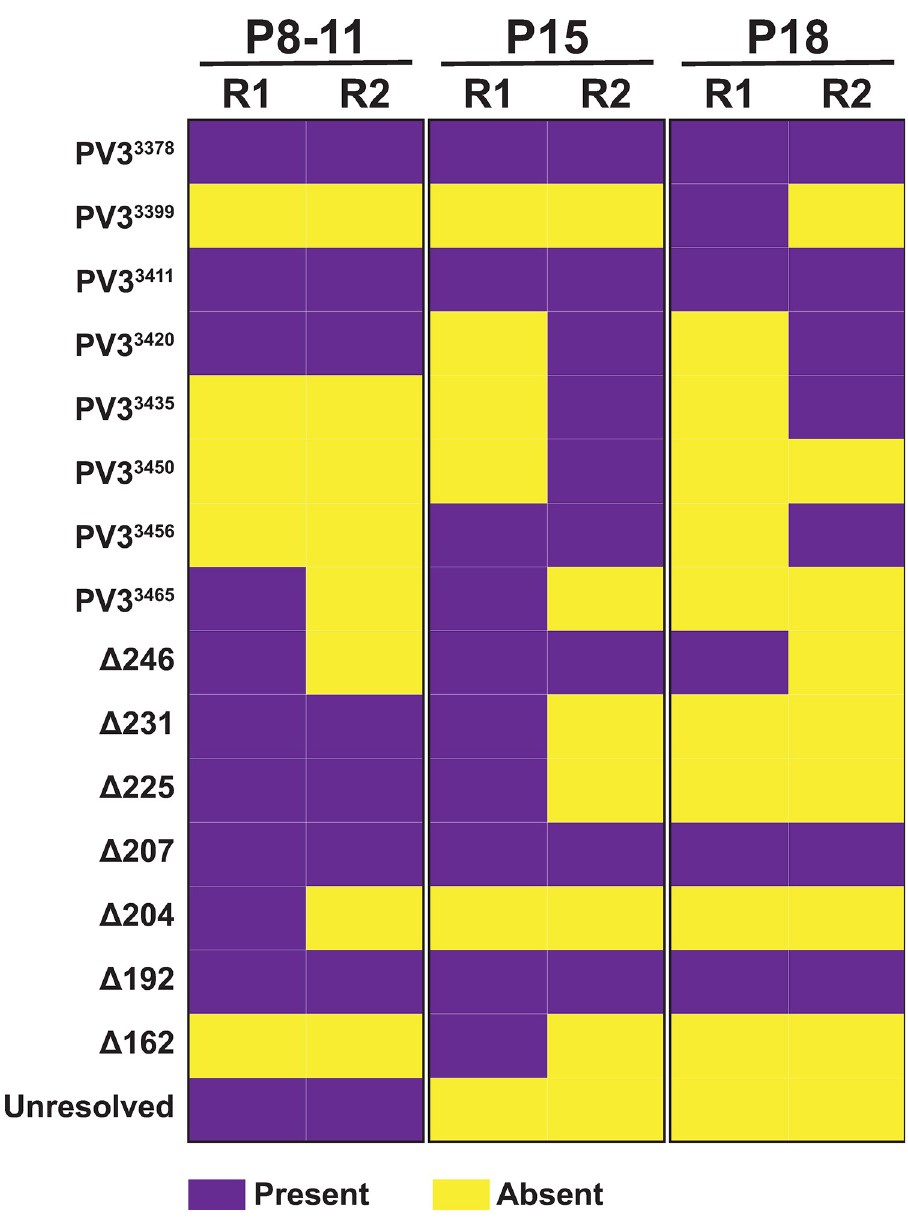
Fig 4. Comparison of recombinants identified between #105B nanopore replicates. Each recombinant variant identified from Oxford Nanopore analysis of the three #105B populations, p8-11, p15 and p18, are denoted as either present (purple) or absent (yellow) from passaging replicates (R) 1 and